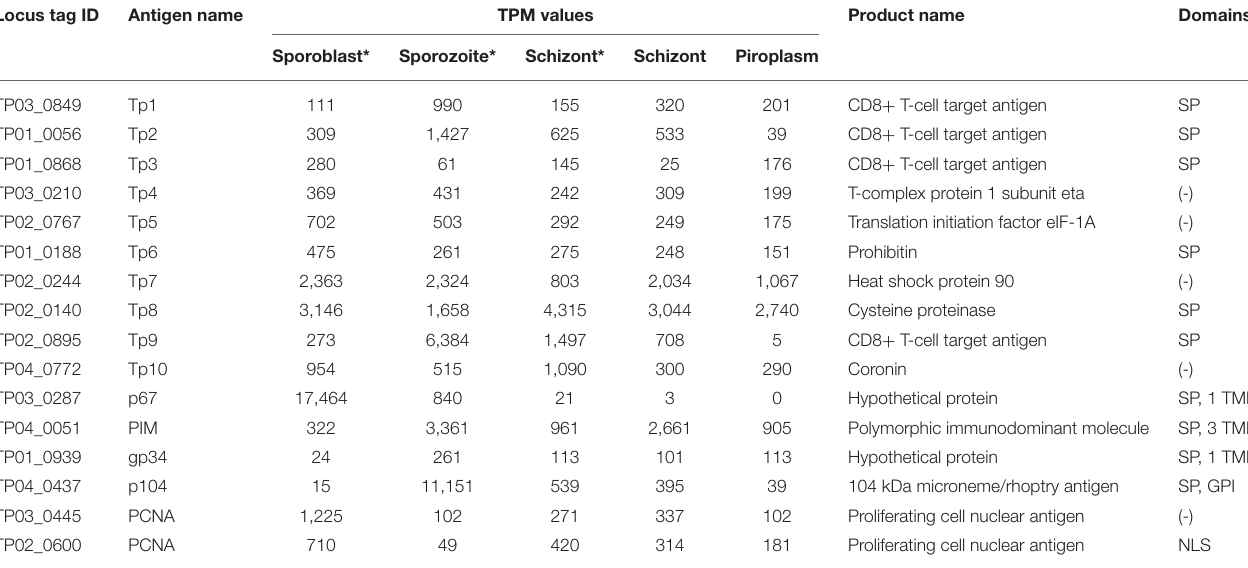
TABLE 4 | Expression profile of known T. parva antigens. Locus tag